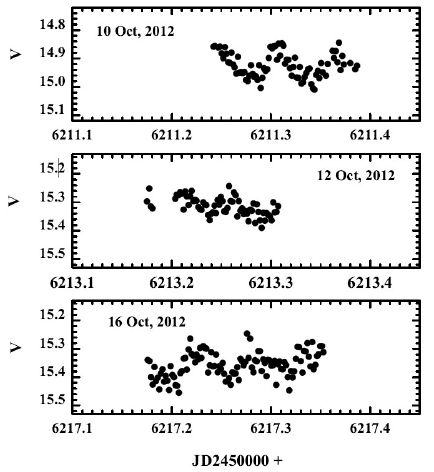
Figure 3: Stage B superhumps in the light curves of dwarf nova